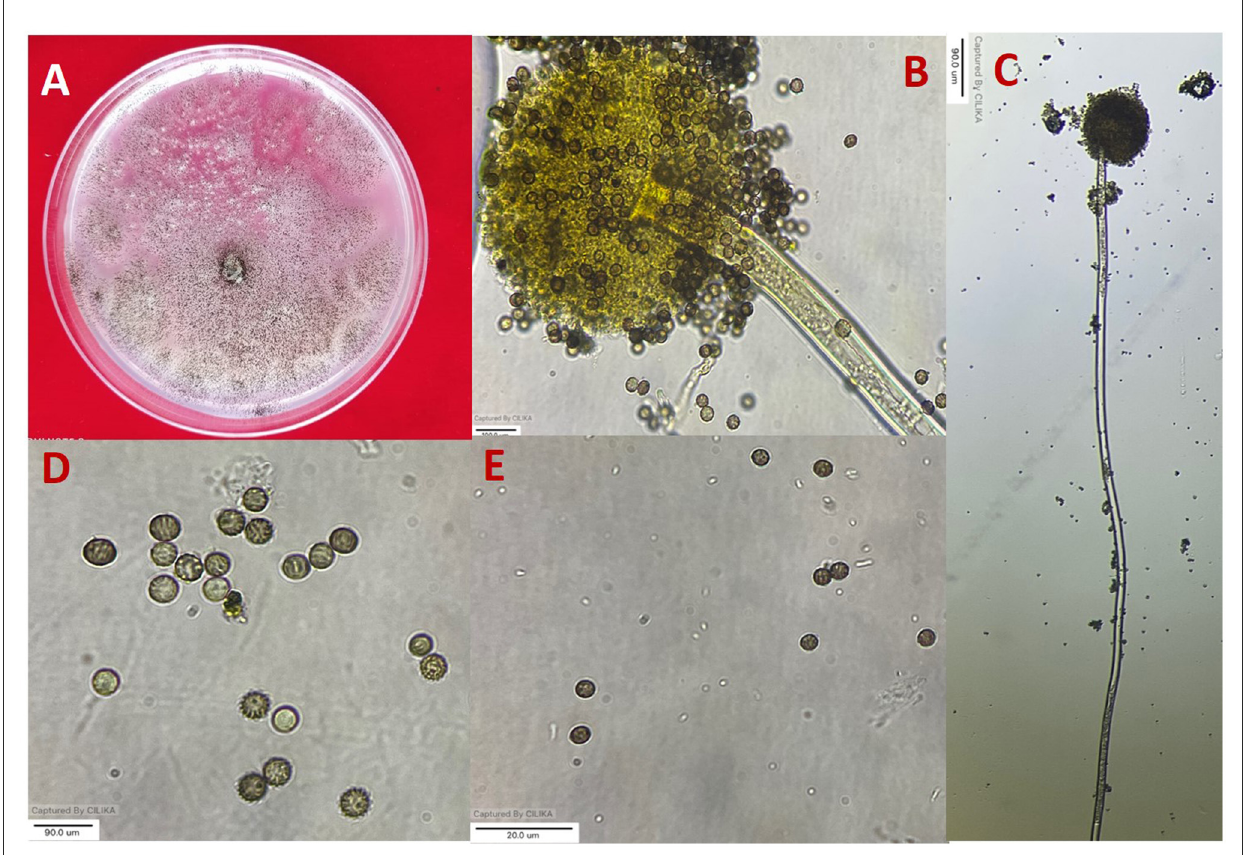
FIGURE1 Morphological characterization of A. niger (A) colony on potato dextrose agar (PDA). (B, C) Conidiophore and vesicle-containing conidia. (D, E) Conidia.